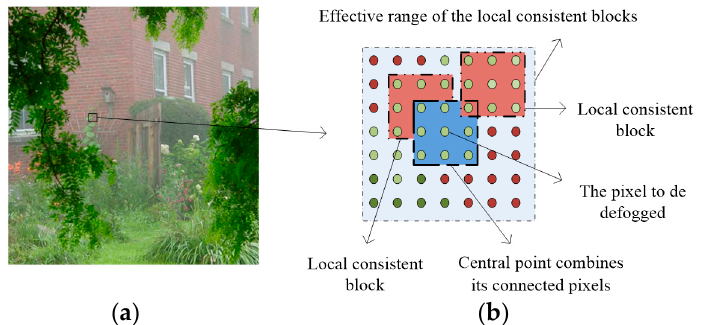
Figure 2. Local consistent Markov random field (MRF). ( a ) The input image; and ( b ) The local consistent blocks.